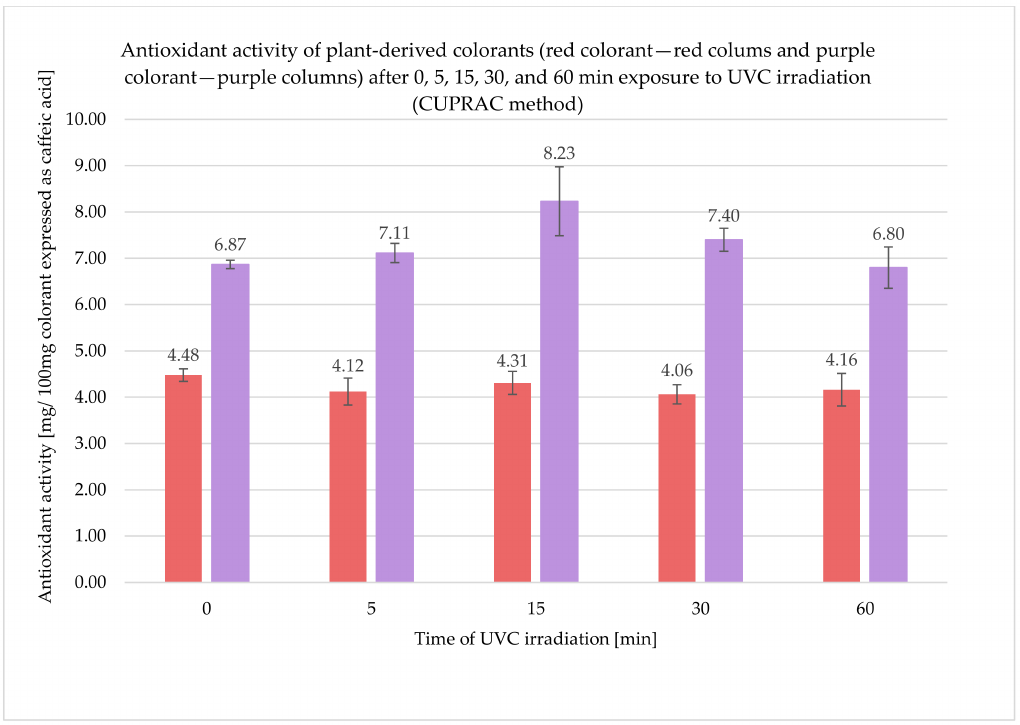
Figure 1. Results of antioxidant activity of plant-derived colorants (red and purple) after 0, 5, 15, 30, and 60 min exposure to UVC irradiation (CUPRAC